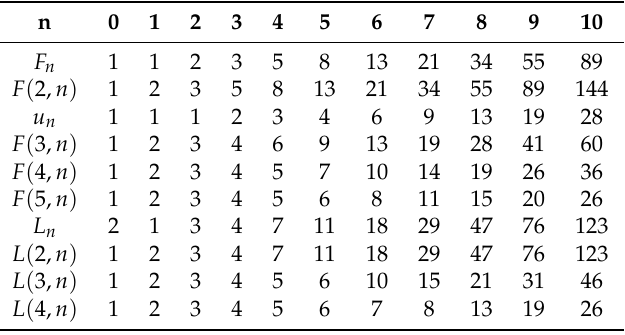
Table 2. The values of F ( p , n ) , L ( p , n ) , F n , u n and L n